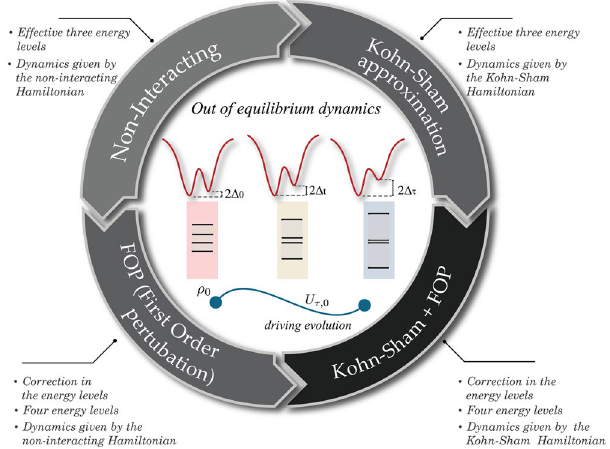
Figure 1. Illustration of the application of the protocols to the Hubbard dimer. This results in four possible approximations to obtain out-of-equilibrium dynamics and related thermodynamic quantities for the Hubbard dimer. These approximations can be used depending on the desired precision and the regime of interest. The worse-case scenario is to use a standard zero-order non-interacting Hamiltonian to describe the system and the dynamics. For more precision, and depending on the regime of interest, we can use either the Kohn-Sham Hamiltonian to describe system and dynamics, or use the standard zero-order non-interacting Hamiltonian for the dynamics but refine the approximation of the initial and final energy spectra (here done up to first order perturbation, FOP): the implementations of both options have similar degrees of difficulty. Finally, we can combine the Kohn-Sham Hamiltonian for the dynamics and the FOP (or higher order precision) for the initial and final